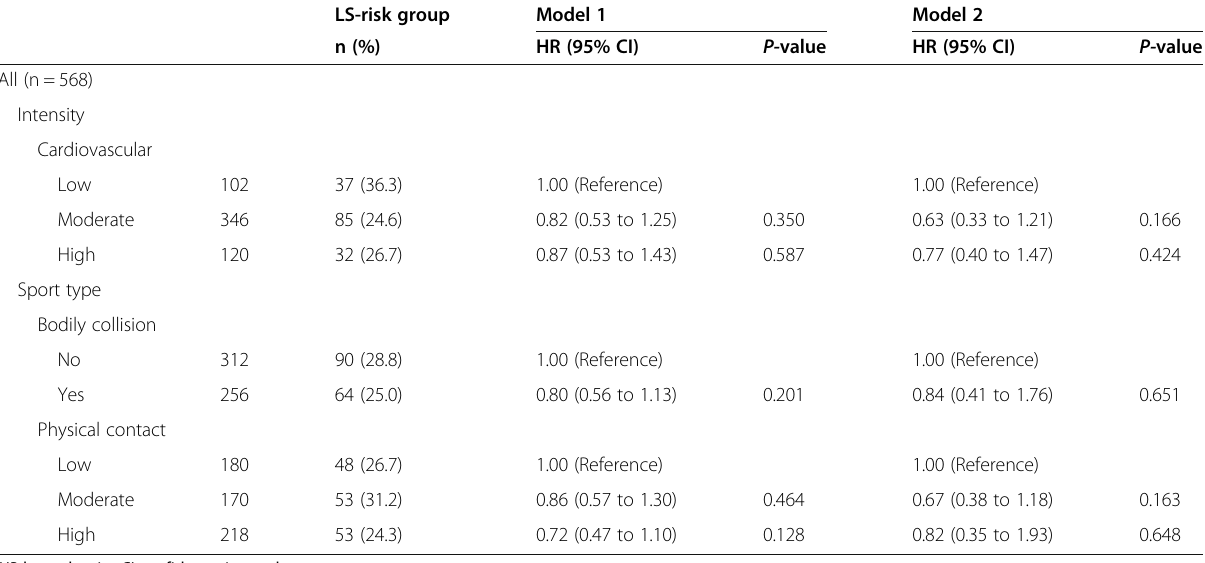
Table 3 Hazard ratios associated with locomotive syndrome according to different intensity of exercise and risk of bodily collision and physical contact based on all sample